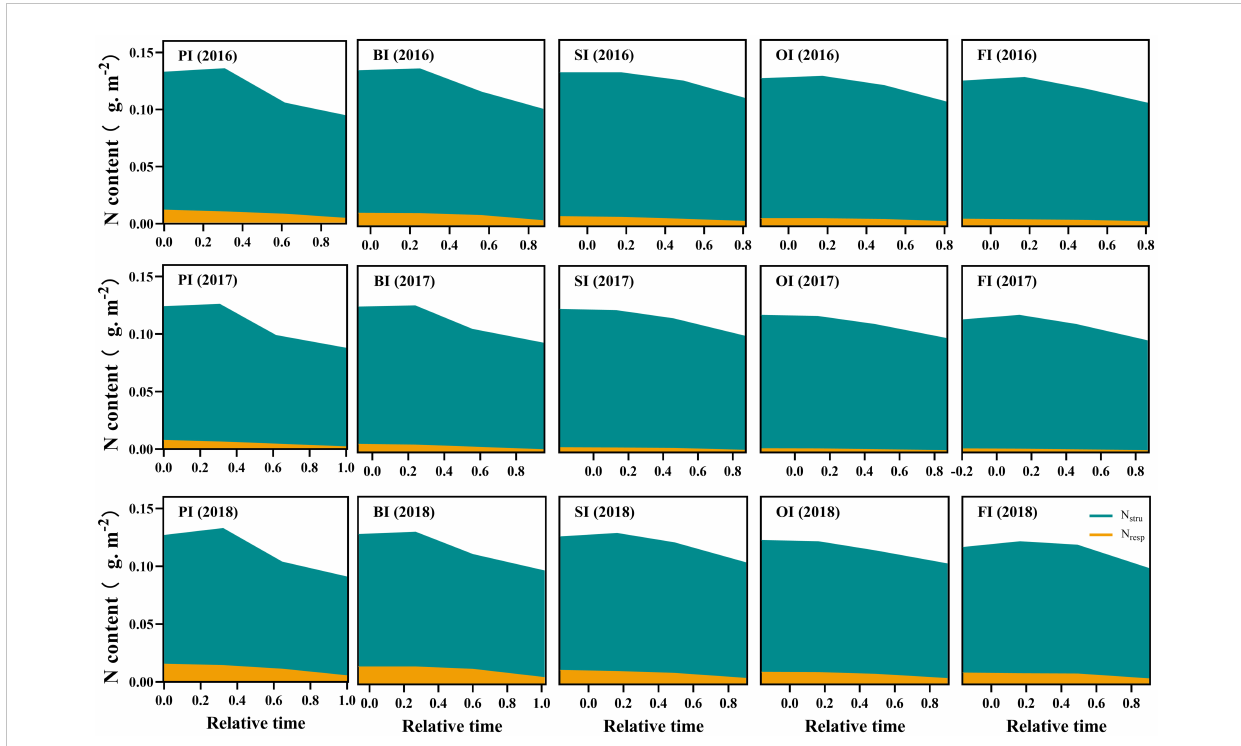
FIGURE 4 Leaf respiration protein N ( N resp ) and structural protein N ( N stru ) dynamics during the reproductive period. PI and BI represent drip irrigation under plastic fi lm mulch and biodegradable fi lm mulch, respectively; SI, drip irrigation incorporating straw returning; OI, drip irrigation with the tape buried to a shallow soil depth; FI, furrow irrigation. Relative time is the ratio of days after silking to the duration from silking to maturity. The data in this fi gure are presented in Table S4 for further